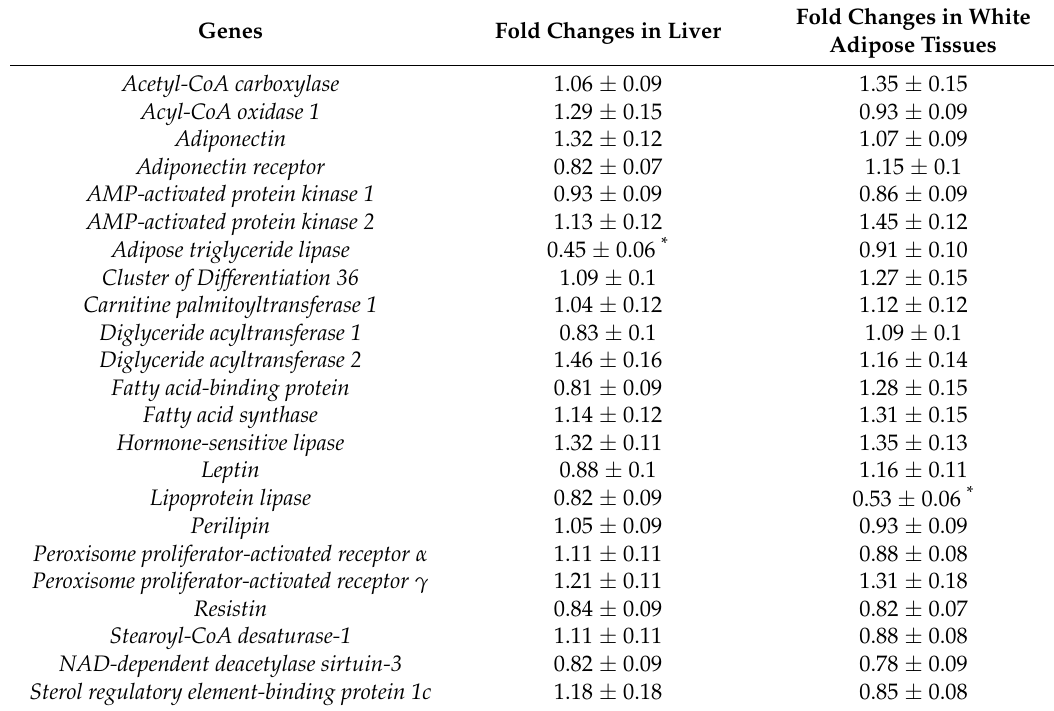
Table 2. The relative mRNA expression of genes involved in hepatic and adipose lipid metabolism in three-week-old male offspring of dams supplemented with folic acid compared with their control counterparts ( n = 10).